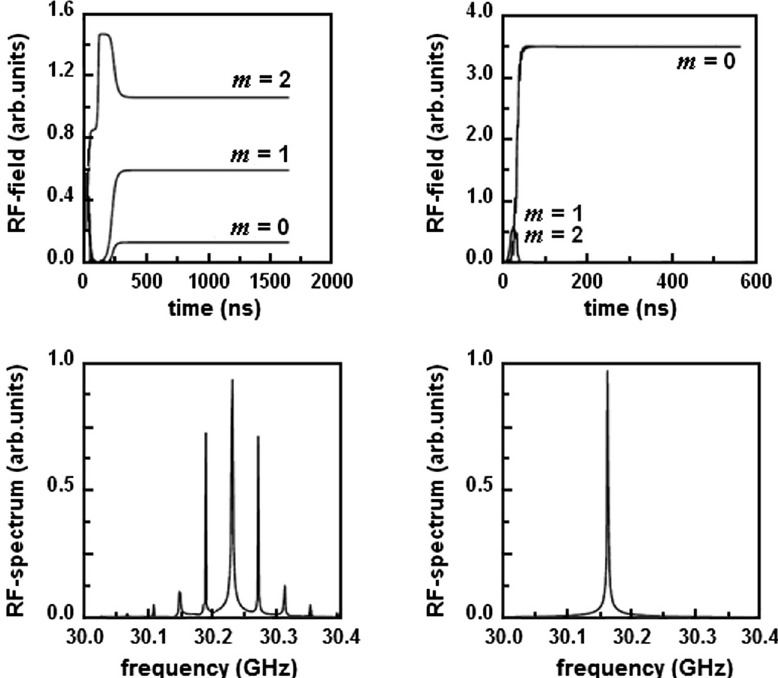
= λ ∼ 16 with (right column) and without (left column) the x 50 A. beam ¼